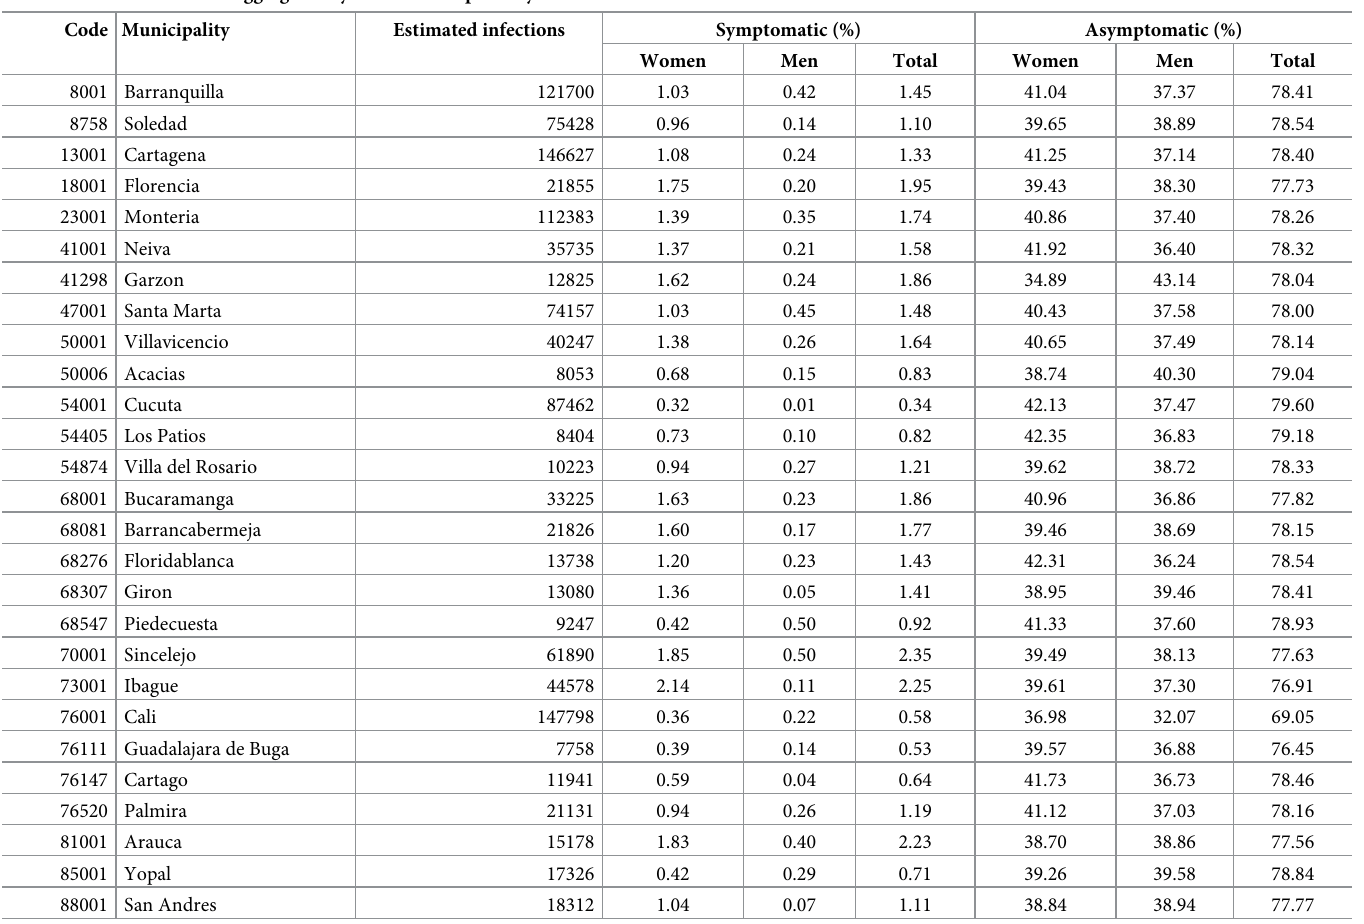
Table 6. ZIKV infections disaggregated by transmission